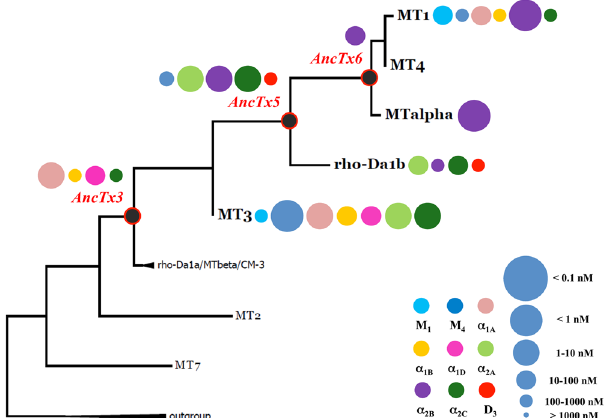
Figure 8. Maximum likelihood tree and associated function of the aminergic toxins from MT3-MT1 evolutionary pathway. Bootstraps value higher than 50% are shown. Toxin’s functions are illustrated by circles identifying the receptor targeted (color) and the corresponding K i value (circle size), as described in the right legend, at the right side of each toxin name.